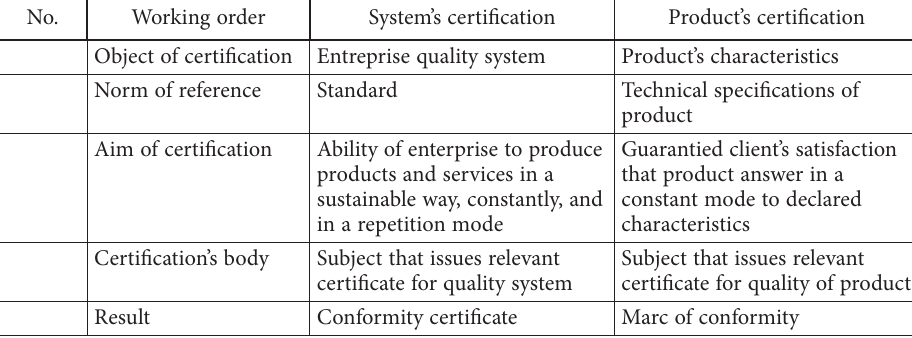
Table 1. Differences between quality system’s certification and product’s certification (source: Ceko, 2017)